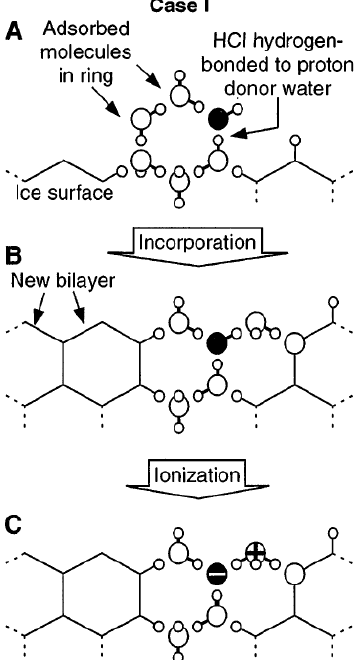
Fig. 5. Molecular dynamics model results for the adsorption of HCl molecule to an ice surface via ionization to form a chloride ion and a H 3 O + ion, as indicated in (C) . Taken from Gertner and Hynes (1996). Reprinted with permission from